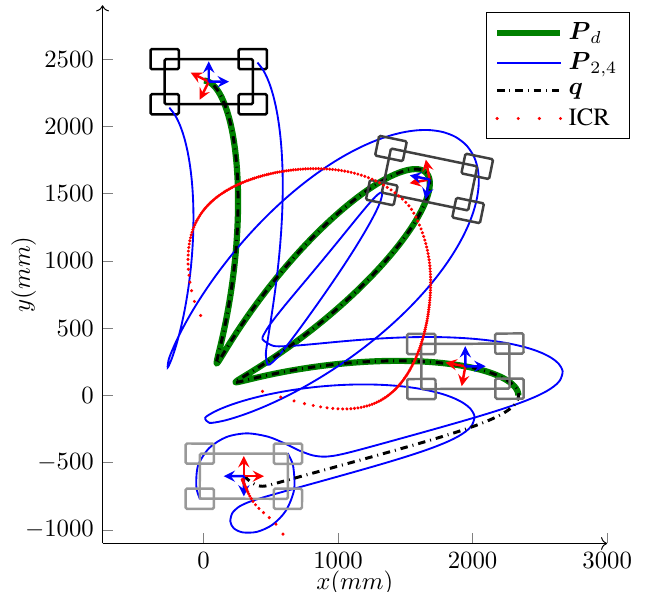
Figure 8. Simulation : Path-following with large initial errors of a WMR with four Swedish wheels ( δ = ( 3,0 ) ). It seeks and follows the path P d , while correcting its heading from the initial error of 180 ◦ to the desired heading of 360 ◦ at the end of the path. −